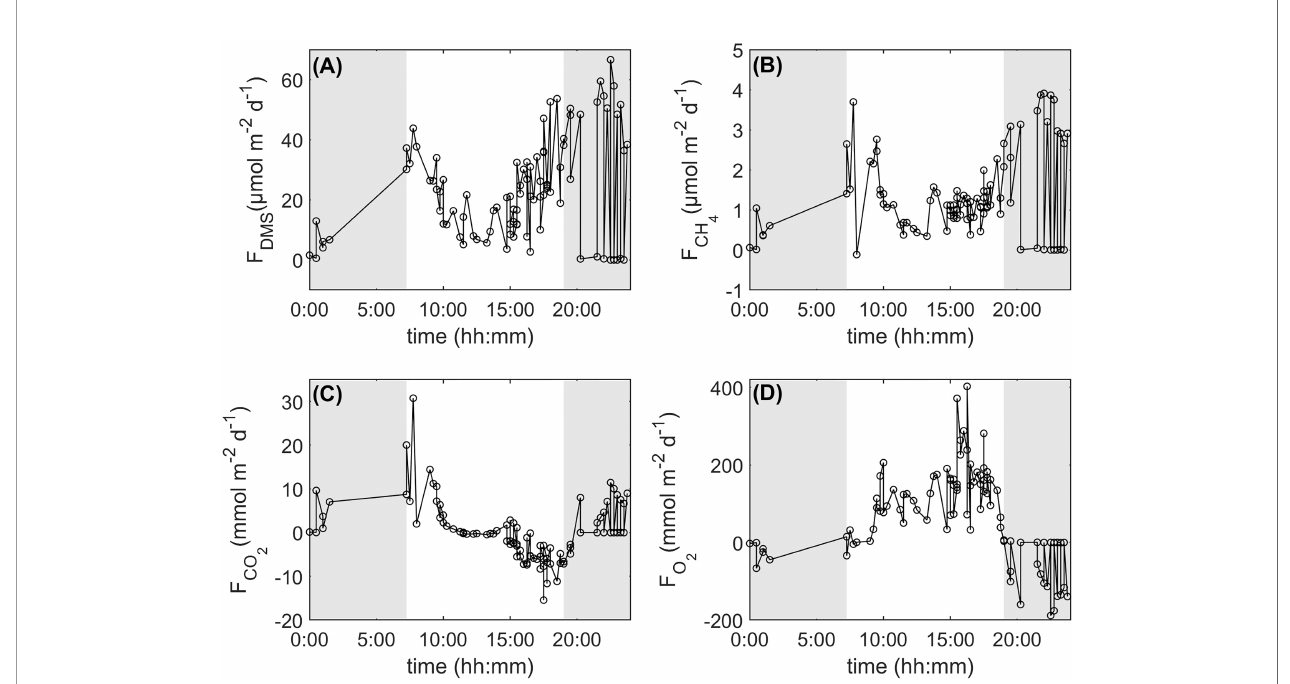
FIGURE 1 | 24-h integrated DMS (A) , CH 4 (B) , CO 2 (C) and O 2 (D) fl uxes from the Heron Island reef, southern Great Barrier Reef, for the period 4-17 February, 2016. Shaded areas represent hours of